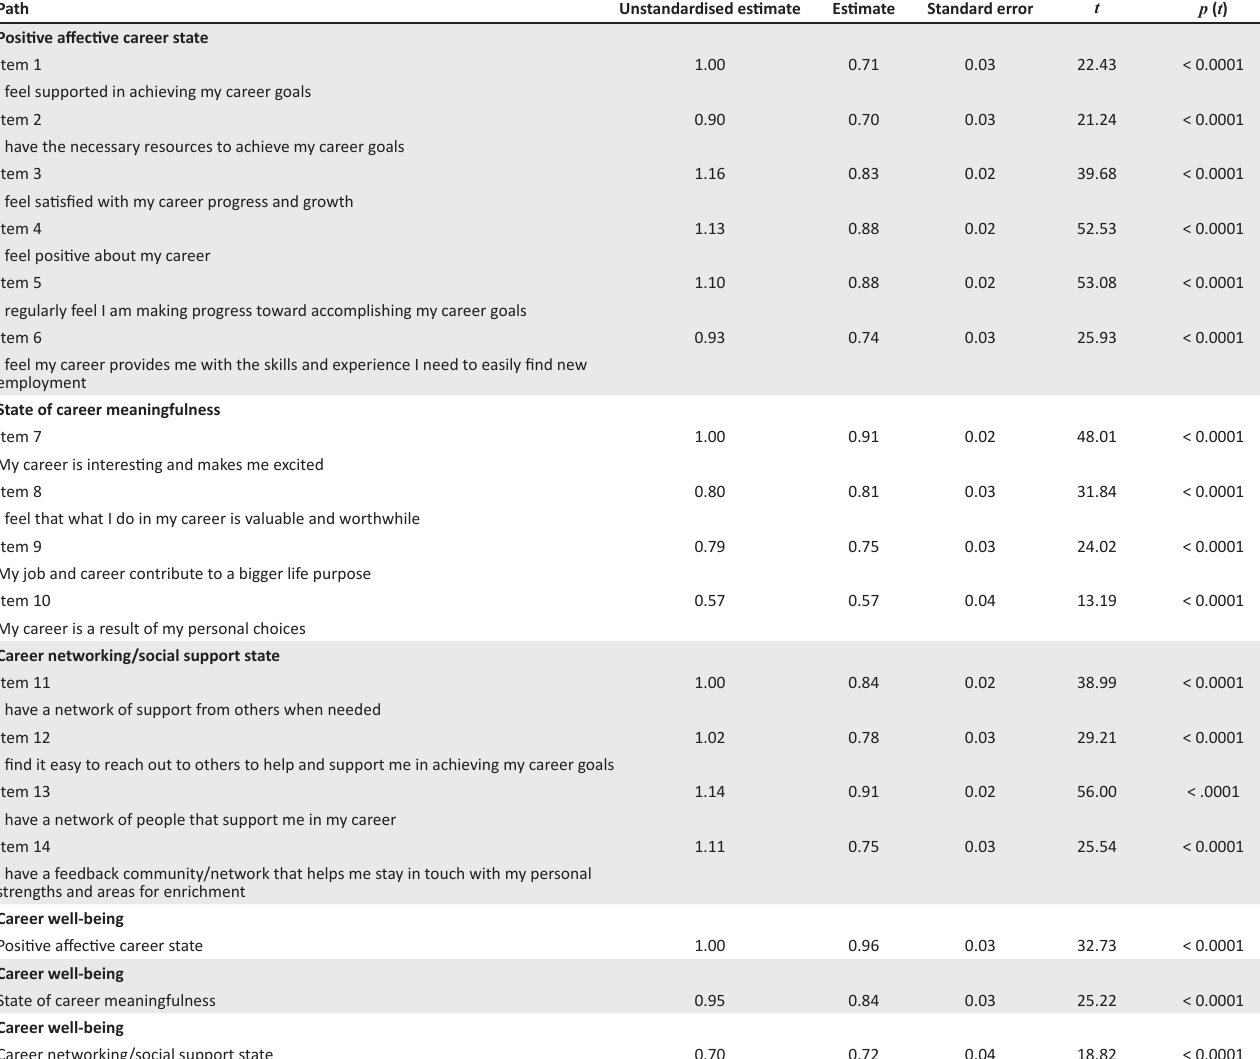
TABLE 5: Standardised path coefficients of the Career Well-being